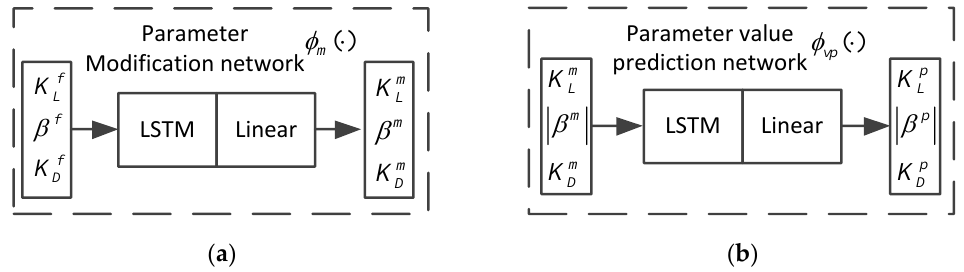
Figure 2. The structure of Network: ( a ) parameter modification network; and ( b ) parameter value prediction network.